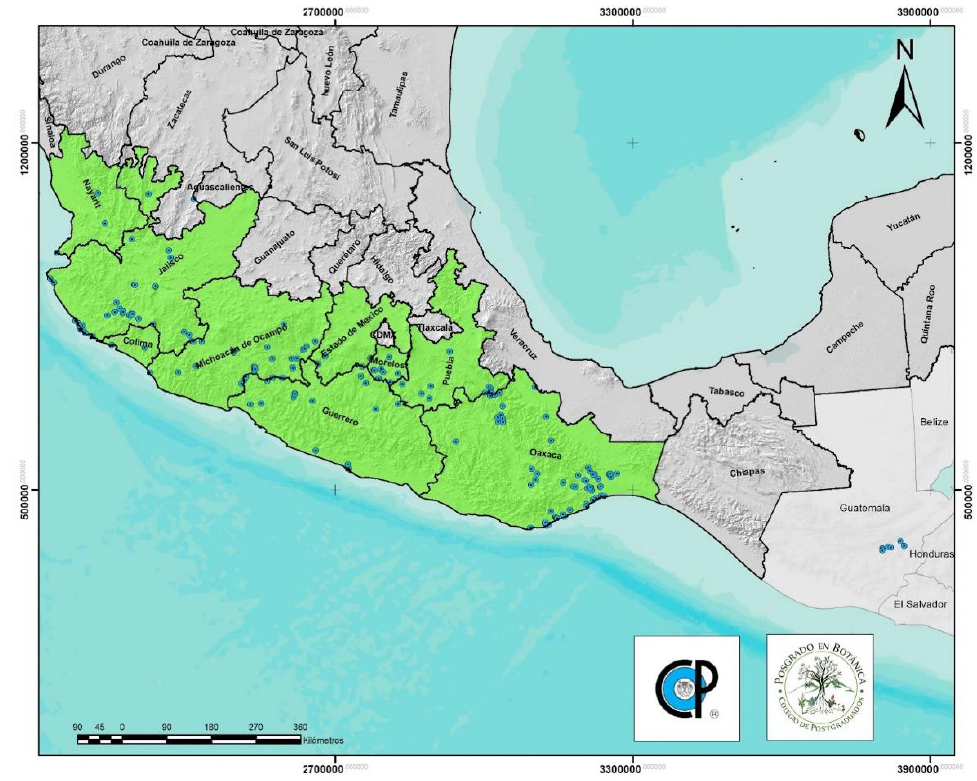
Figure 4. Geographic distribution of A. adstringens . The blue dots indicate locations where samples were collected. The World Information Network on Biodiversity (REMIB, CONABIO), W 3 Tropicos ®